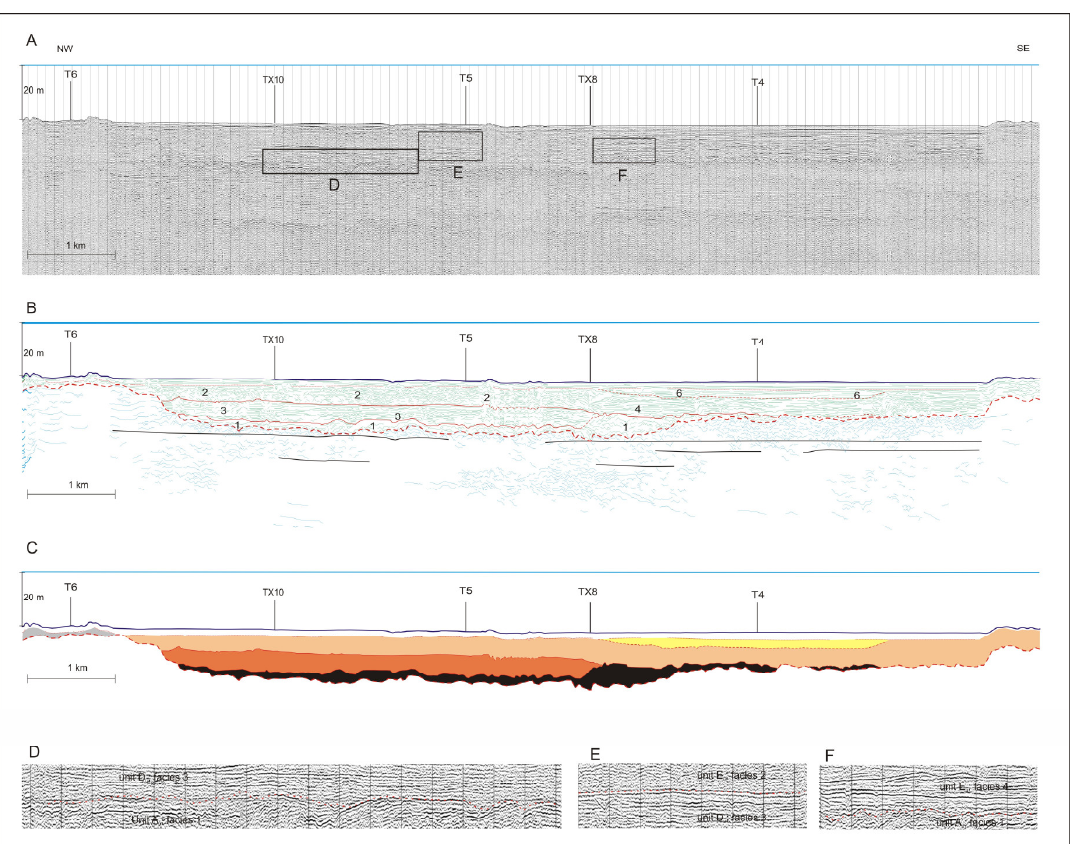
Figure 11. Part of seismic profile PX2. Seismic section ( A ), its interpretation ( B ), seismic units recognised ( C ), enlargement of some significant sectors of the unconformities between units ( D–F ). The evidence that the unit D u is intercepted by this profile only in the NW sector of the OSFV indicates that this system is much more extended into the OSFV in this sector than that of the SE. Note also the position of the central body of unit E u (seismic facies 2) above the backbarrier deposits of the previous unit D u (seismic facies 3) and the transition, within unit E u , between the central body at the NW (seismic facies 2) and the seismic facies 4 in the SE sector.